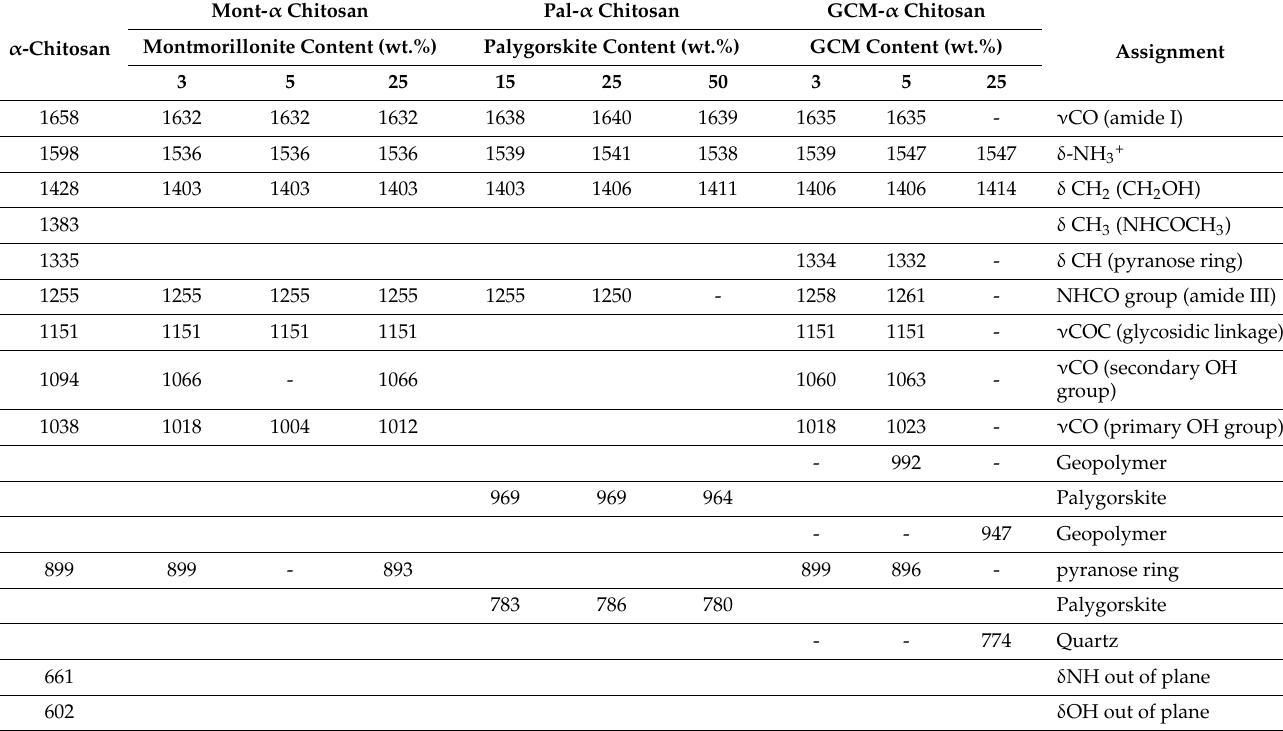
Table 1. Frequencies (cm − 1 ) and assignments of FT-IR bands of pure and filler-containing chitosan-based film spectra. Mont- α Chitosan Pal- α Chitosan GCM- α α -Chitosan